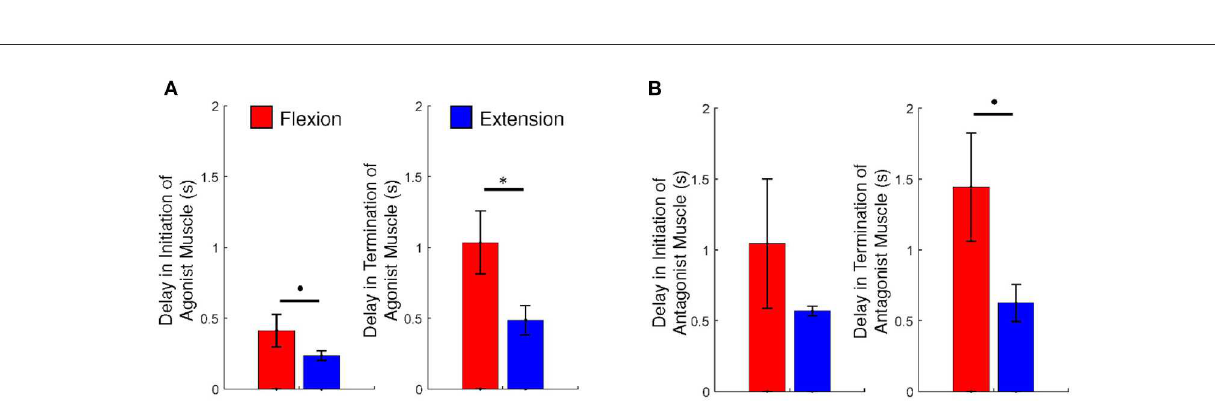
FIGURE3 (A) The delays of initiation and termination of the agonist muscle and (B) the ratios of antagonist muscle activation and the net torque, during voluntary flexion and extension. An asterisk indicates statistical significance ( p < 0.05) and a dot indicates marginally statistical significance ( p < 0.1). Error bars are ± 1 standard error of the mean.